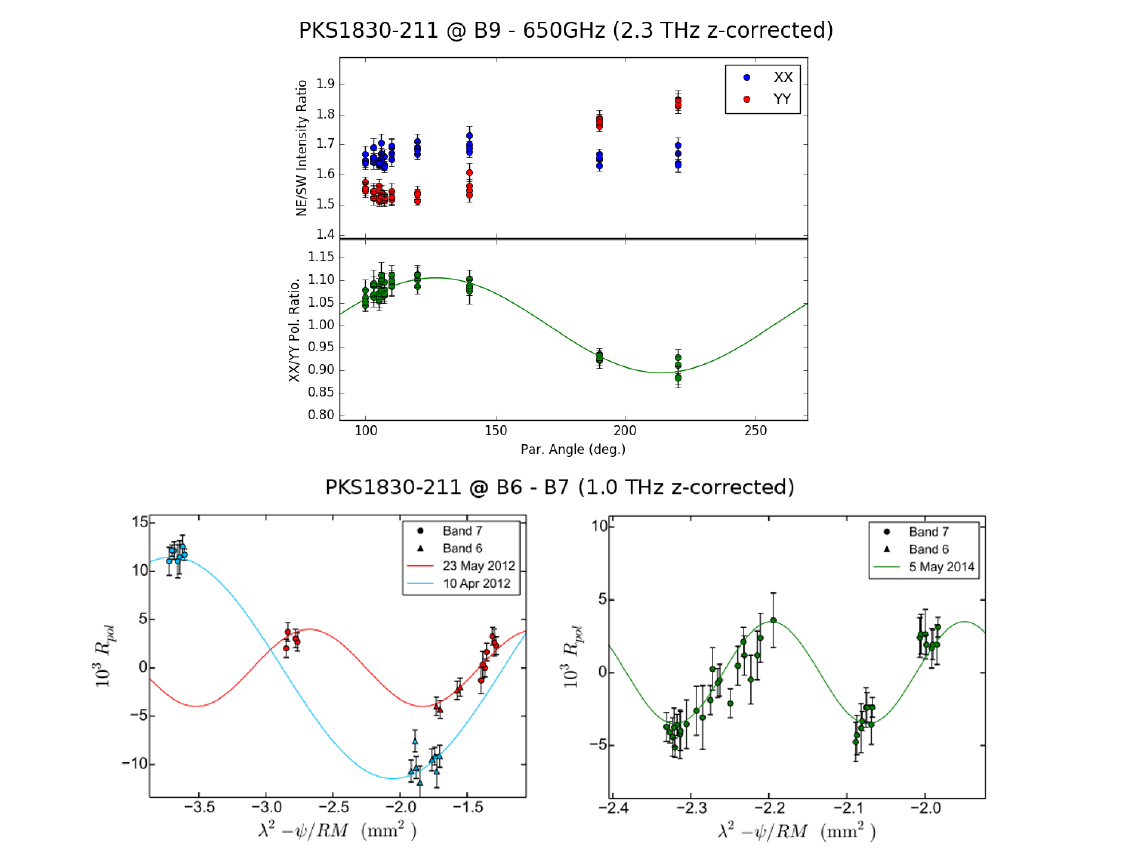
Figure 5. Top : polarization ratios of the image contrast of PKS1830 − 211 in Band 9 (Muller et al., in prep). Notice the clear sinusoidal dependence of the ratio as a function of parallactic angle. Bottom : Polarization ratios of the image contrast of PKS1830 − 211 around 1mm (adapted from [23], which is an update of [14]). Notice how the sinusoid depends on parallactic angle and